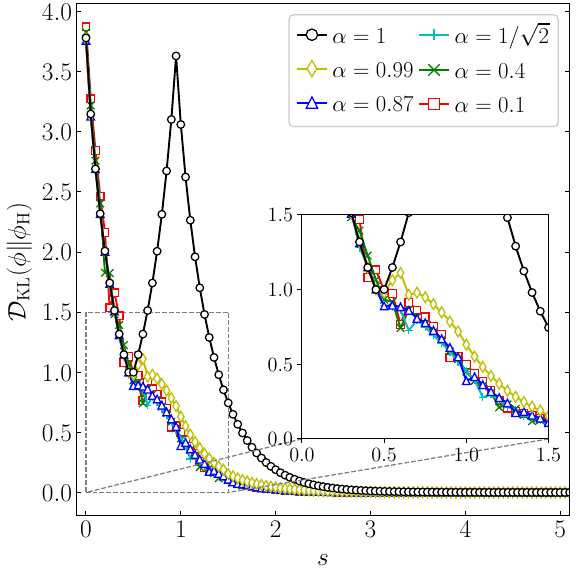
φ H ) in the velocity-inversion ex- Figure 2. Evolution of ( φ D KL k periment (with a waiting time s w = 0 . 5). Symbols represent MD simulation results (joined with straight lines as a guide to the eye). The values of the coe ffi cient of restitution are α = 0 . 1, 0 . 4, 1 / √ 2, 0 . 87, 0 . 99, and 1. The inset magnifies the behavior around s = 0 . 5. The error bars are smaller than the size of the